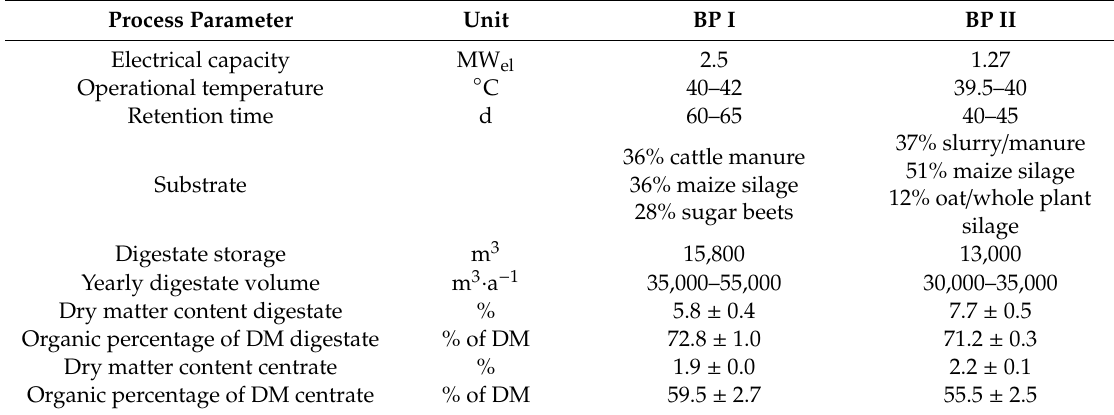
Table 1. Process parameters of biogas plants BP I and BP